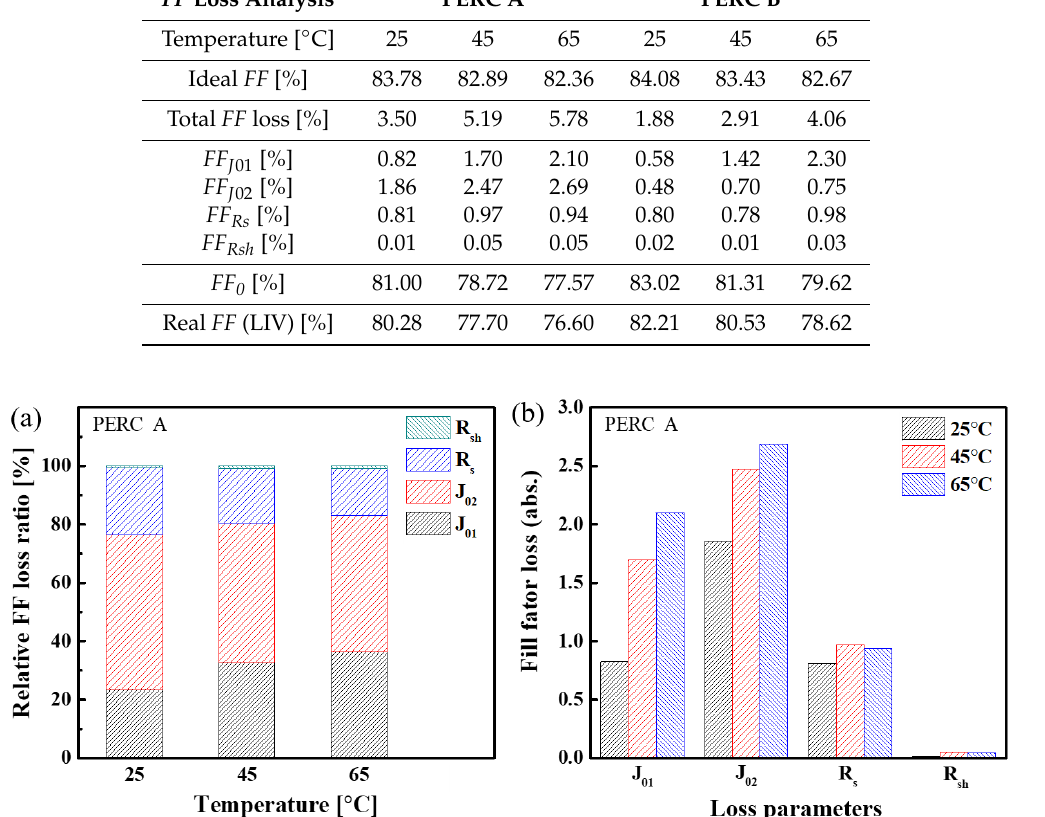
Figure 5. Fill factor loss analysis results of PERC A: ( a ) Normalized fill factor ratio; ( b ) Absolute fill factor loss.